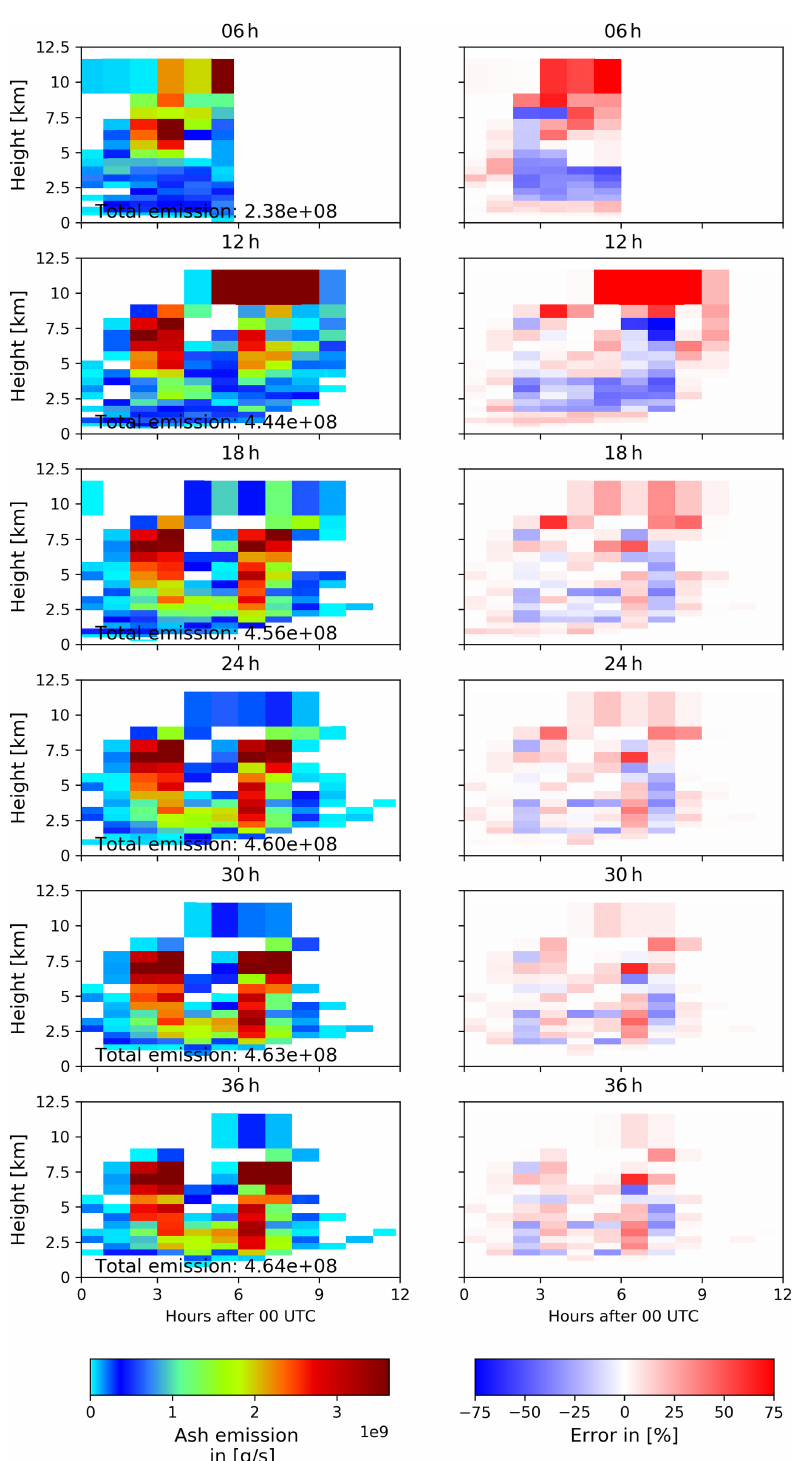
Figure A1. Emission profile of the ensemble mean (left panels) and its relative error to the nature run emission profile (right panels) for different assimilation window lengths on 15 April